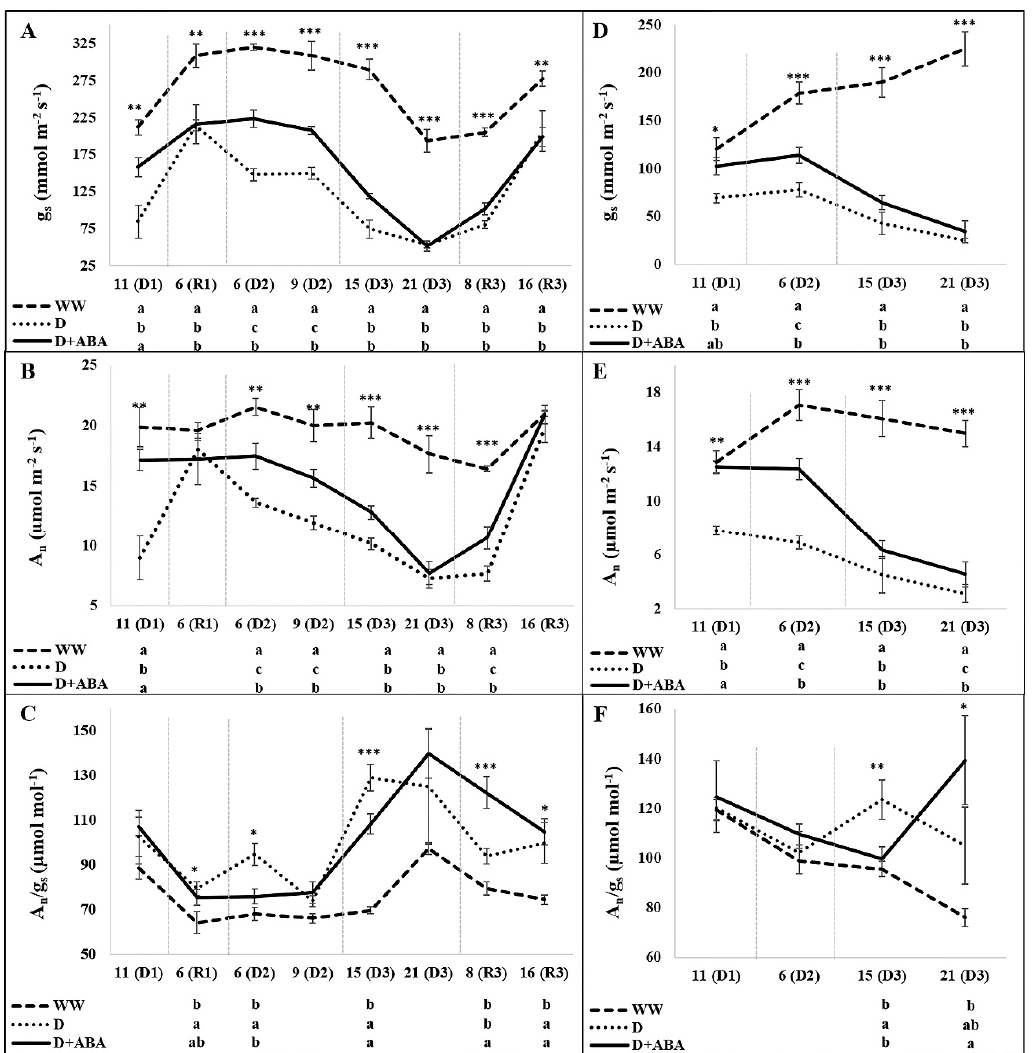
Figure 2. Evolution of stomatal conductance (g s ), net photosynthetic rate (A n ) and intrinsic water use efficiency (A n /g s ) at morning ( A – C ) and midday ( D – F ) periods of days of drought (D1, D2, D3) and recovery (R1, R3) in each cycle, in leaves of well-watered (WW) and droughted without (D) and with abscisic acid (D + ABA) plants. Each point is average and vertical bars represent the S.E. ( n = 8). Different letters indicate significant differences among treatments within each date (* p < 0.05, ** p < 0.01, *** p < 0.001).